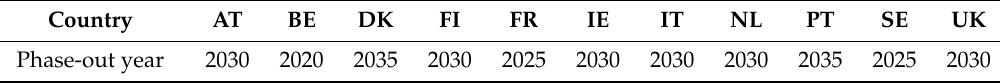
Table 2. Assumed coal-exit dates for European countries (own calculations based on [23]). Country AT BE